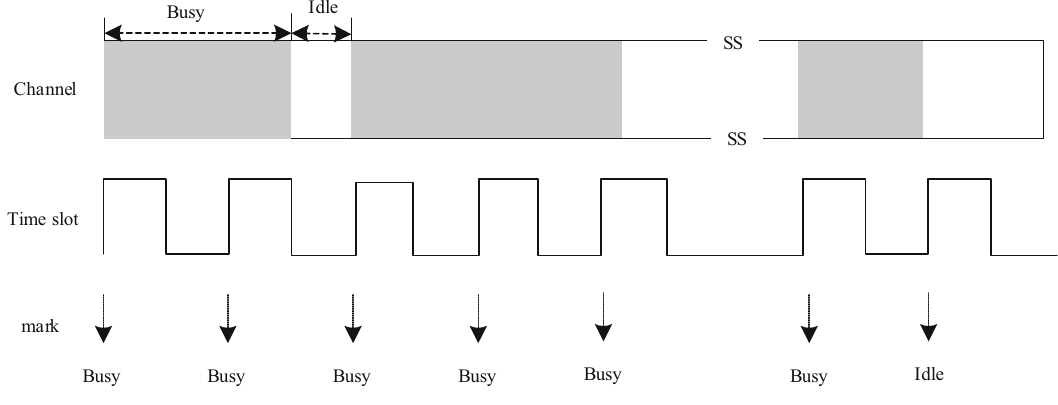
Figure 9: Statistics of channel